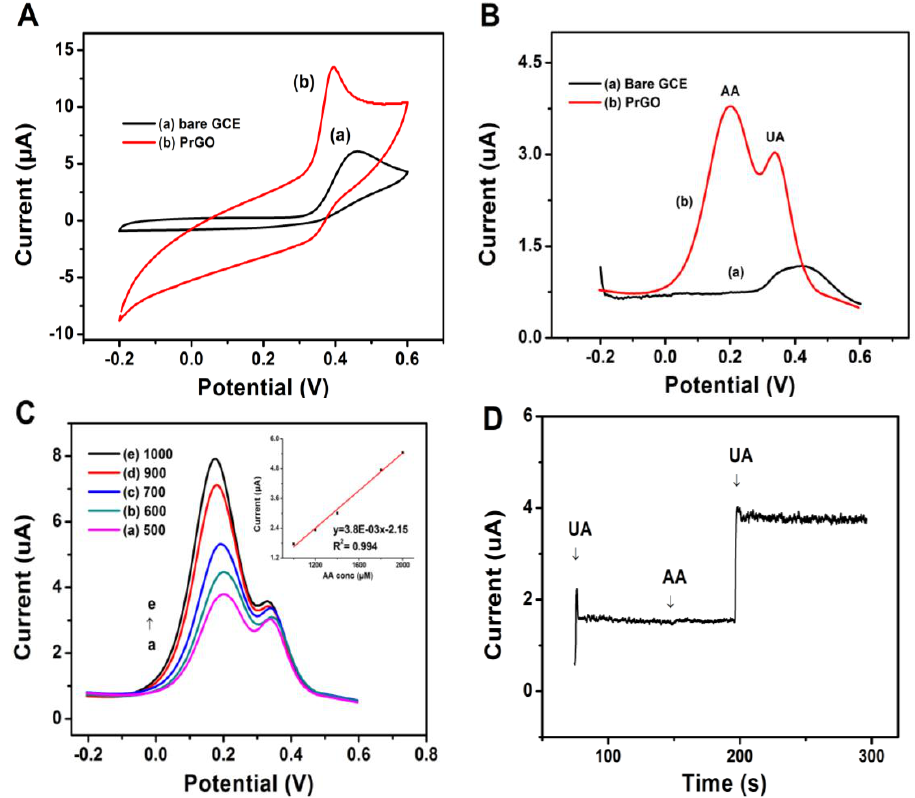
Figure 5. ( A ) CV of 500 μM UA at (a) bare GCE and (b) PrGO in 0.1 M phosphate buffer solution